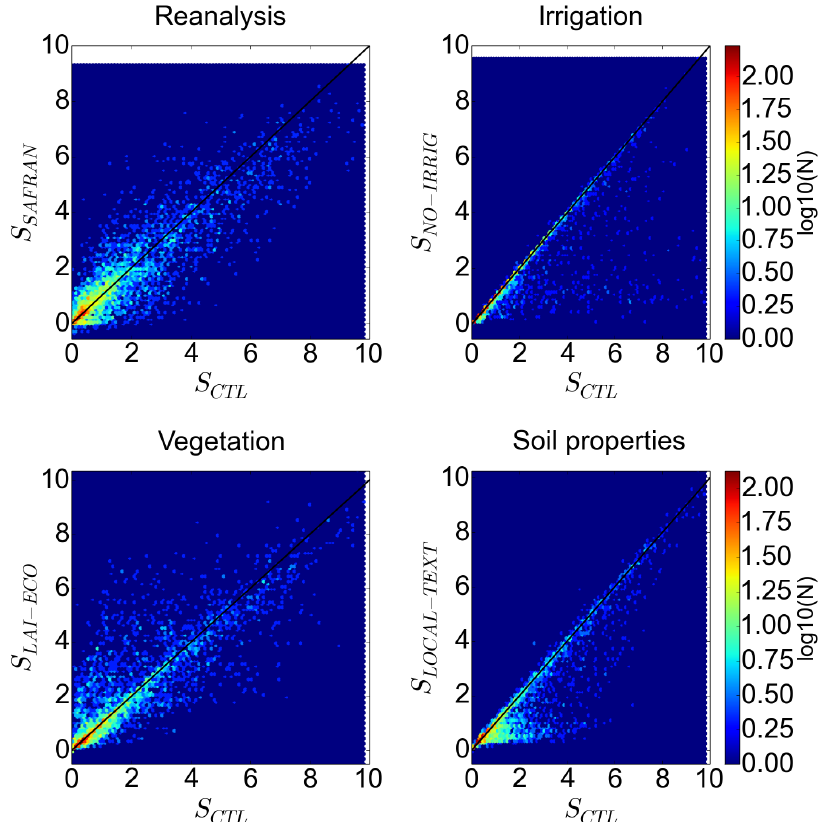
Figure 11. Scattering in daily ET between selected experiments and the control run. N in the colour bar legend is the number of points used to represent the point